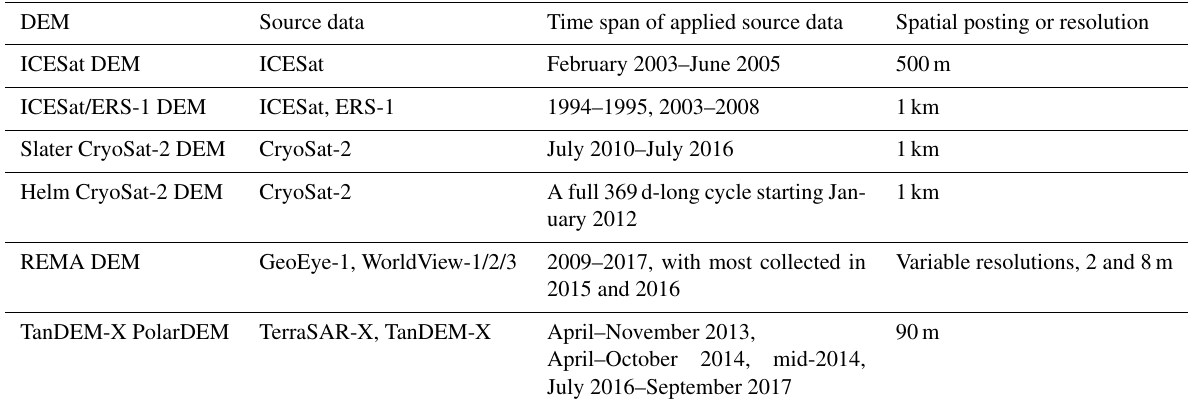
Table 1. Detailed introduction to six previously published Antarctic DEMs, including the source data, time span of the source data, spatial posting or resolution.